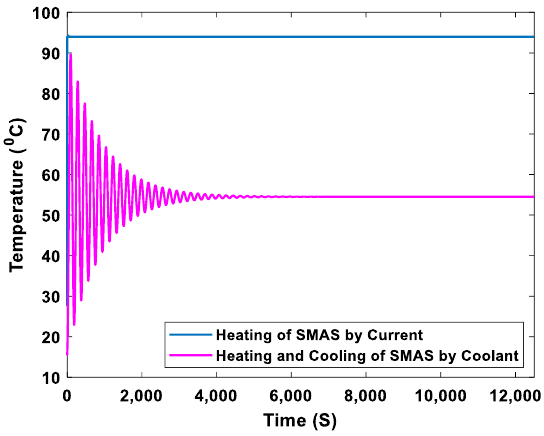
Figure 5. Heating process of the SMA